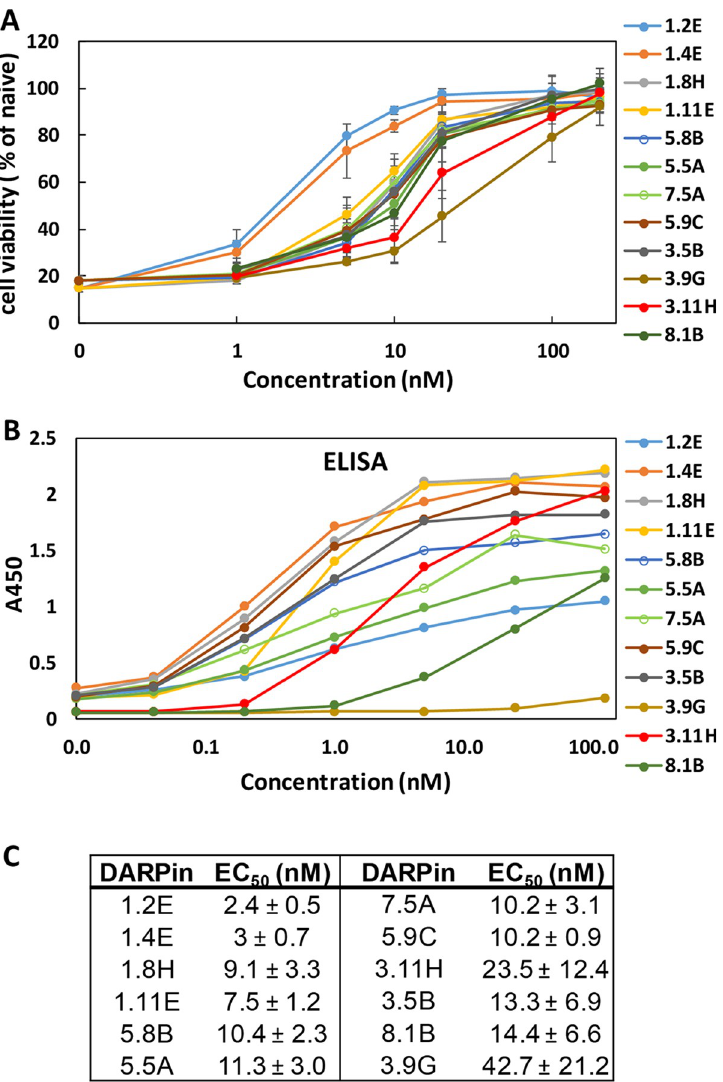
Fig 1. Characterization of leading monomeric DARPin hits. (A) Monomeric DARPins are able to protect Vero cells from TcdB-induced cytopathic effect at nanomolar concentrations. IMAC-purified DARPins were added to Vero cells (2 × 10 3 cells/well) together with TcdB toxin (5 pg/mL). Cell viability was quantified 72 hours later by the CellTiterGlo assay and normalized to na ï ve Vero cells. Error bars represent the standard deviation of at least 2 independent experiments performed in duplicate. (B) Relative binding of DARPins to TcdB was determined using ELISA. Serially diluted DARPins were added to microtiter plates coated with 4 μ g/mL of TcdB. Results are representative of 2 independent experiments. (C) DARPin monomer TcdB-neutralization potency. Data are the averages of at least 2 independent experiments. DARPin, designed ankyrin repeat protein; EC 50 , half maximal effective concentration; ELISA, enzyme-linked immunosorbent assay; IMAC, Immobilized metal affinity chromatography; TcdB, C . difficile toxin B.